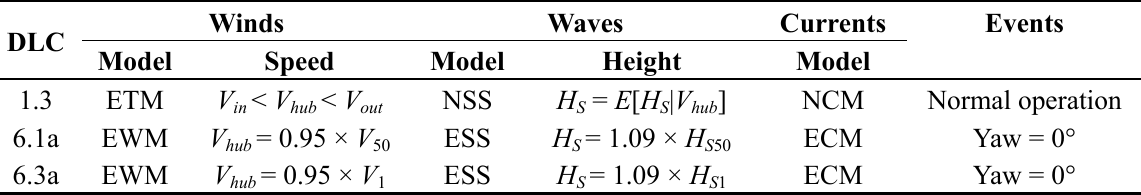
Table 8. Summary of the selected design load